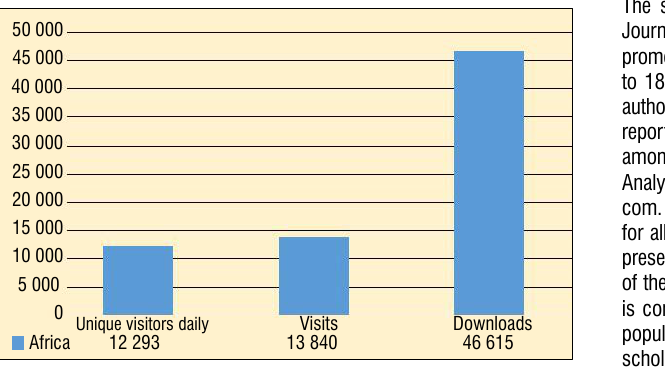
Figure 4: User visits and downloads from Africa for the South African Journal of Libraries and Information Science , 2012–2017.